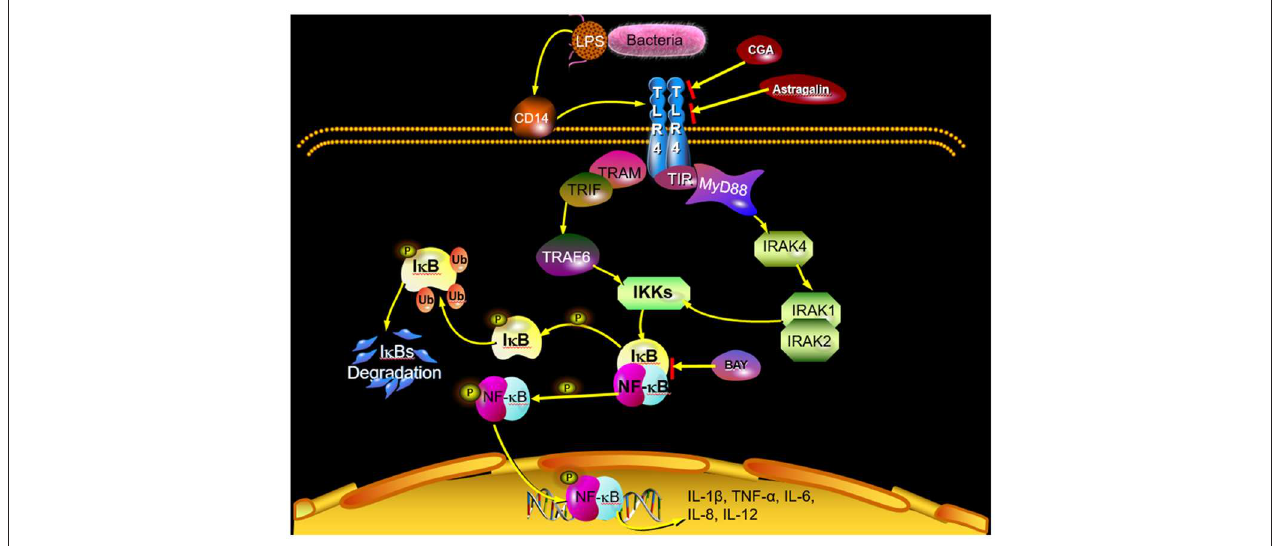
FIGURE 11 | Scheme summarizing the mechanism of the protective effect of astragalin and CGA on E. coli -induced endometritis. E. coli infection activates the TLR4/NF- κ B signaling pathway. Activated NF- κ B can be translocated from the cytosol to the nucleus, where it activates the transcription of genes that include IL-1 β , IL-6, IL-8, IL-12, and TNF- α . Astragalin and CGA could inhibit the inflammatory response by blocking TLR4